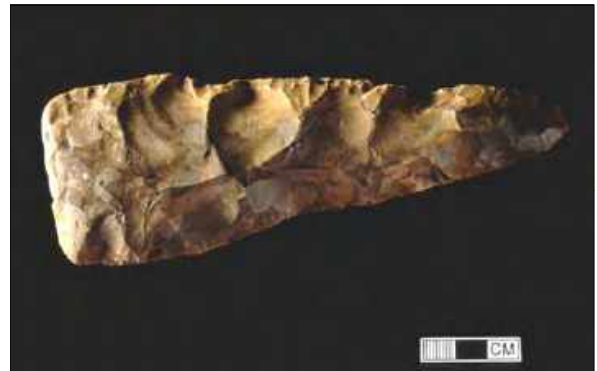
Fig 2.6 Neolithic Axe from Moston, Crewe & Nantwich (Cheshire County